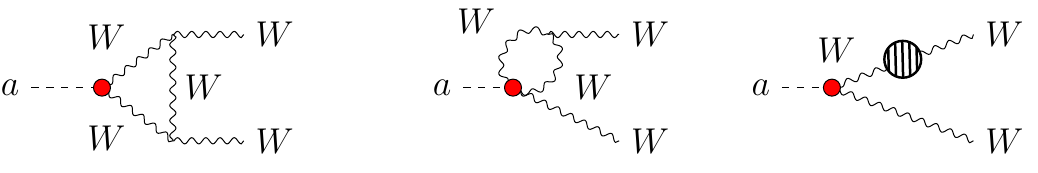
Figure 1 . One-loop diagrams which renormalize the effective a G last diagram stands for one-loop gluon and quark contributions (a similar contribution holds for the other external gauge leg).